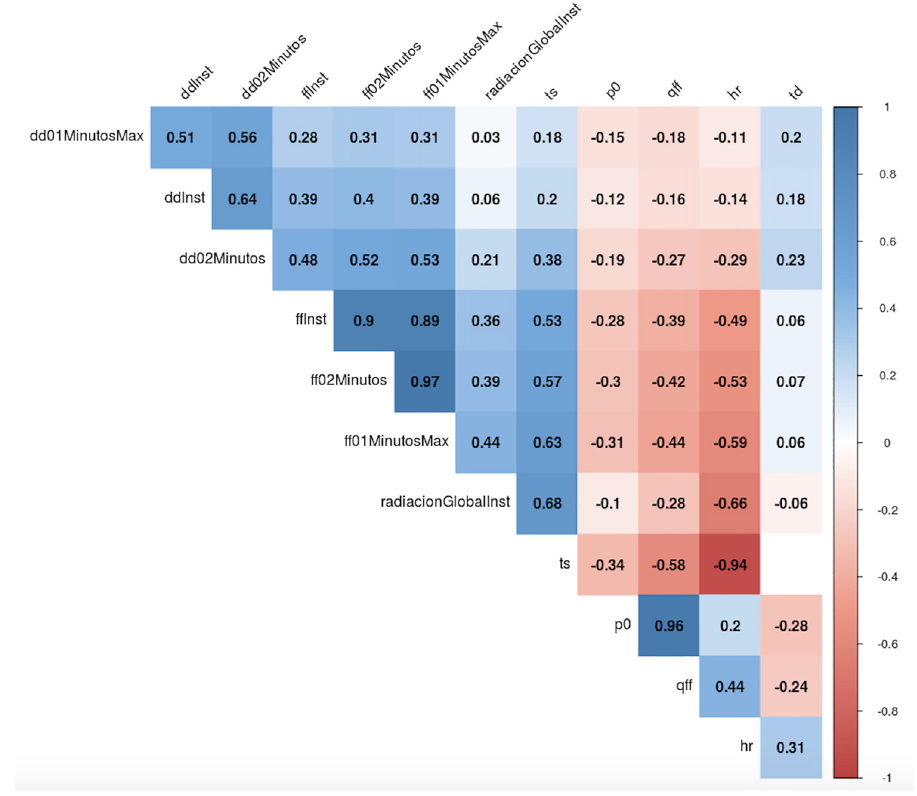
Fig 5. Correlation plot across weather